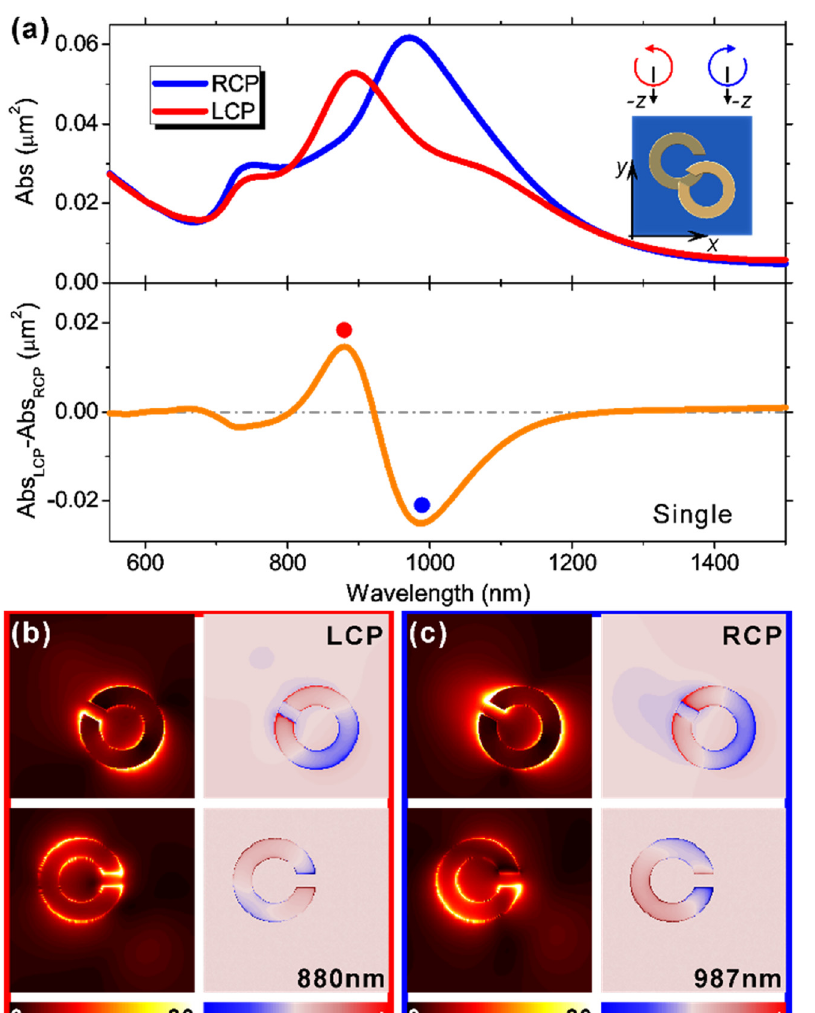
Figure 2: CD response of a single modified gold stereo-SRR dimer. (a) Absorption cross-section spectra of a single D-Enantiomer under LCP and RCP incidences (upper panel) and corresponding differential absorption ( Δ Abs) spectrum, i. e., CD spectrum (lower panel). (b, c) Near-field enhancement ( | E / E 0 | , left panels) and surface charge (right panels)distributionpro fi lesat theABDQ(b) and (c) BDQ resonance